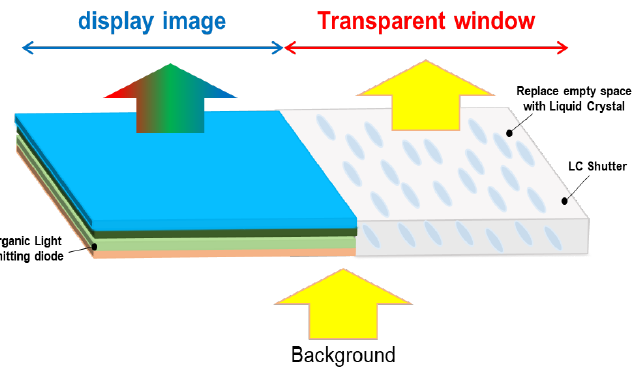
Figure 1. The conceptual diagram of the proposed hybrid-type transparent OLED display.